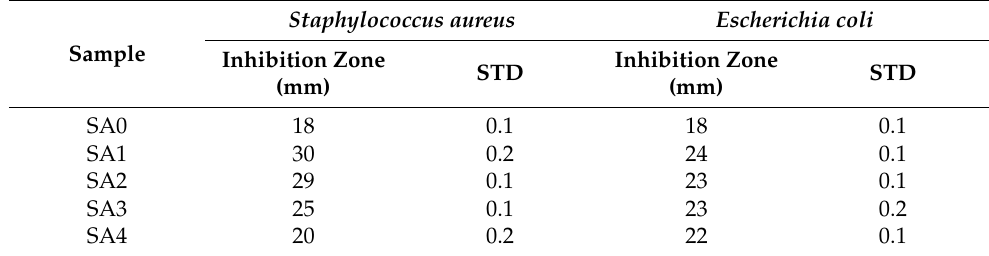
Table 3. Evaluation of the antimicrobial activity of the hydrogels loaded with silver nanoparticles.